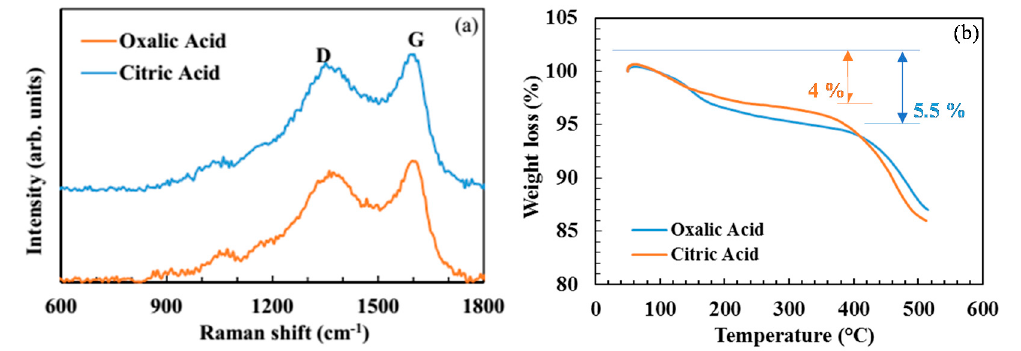
Figure 2. ( a ) Raman spectra and ( b ) TGA curves of the LVP compounds.